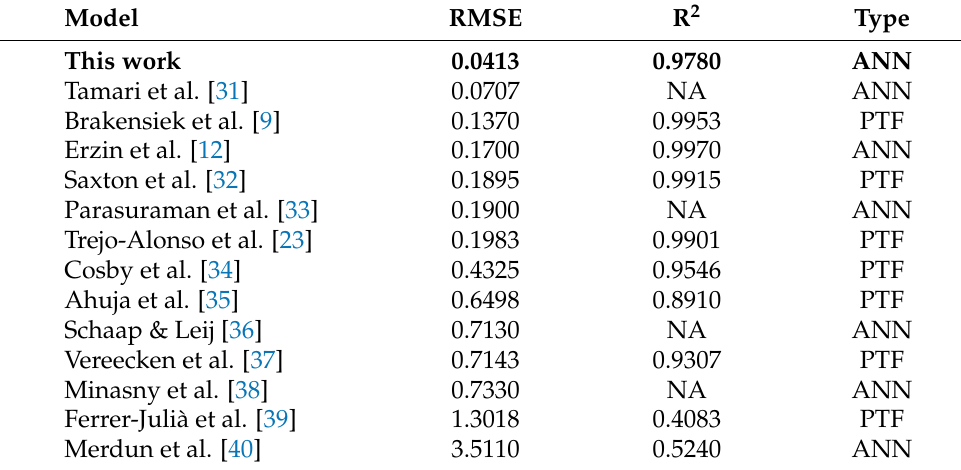
Table 3. Comparison between several works for obtaining K S